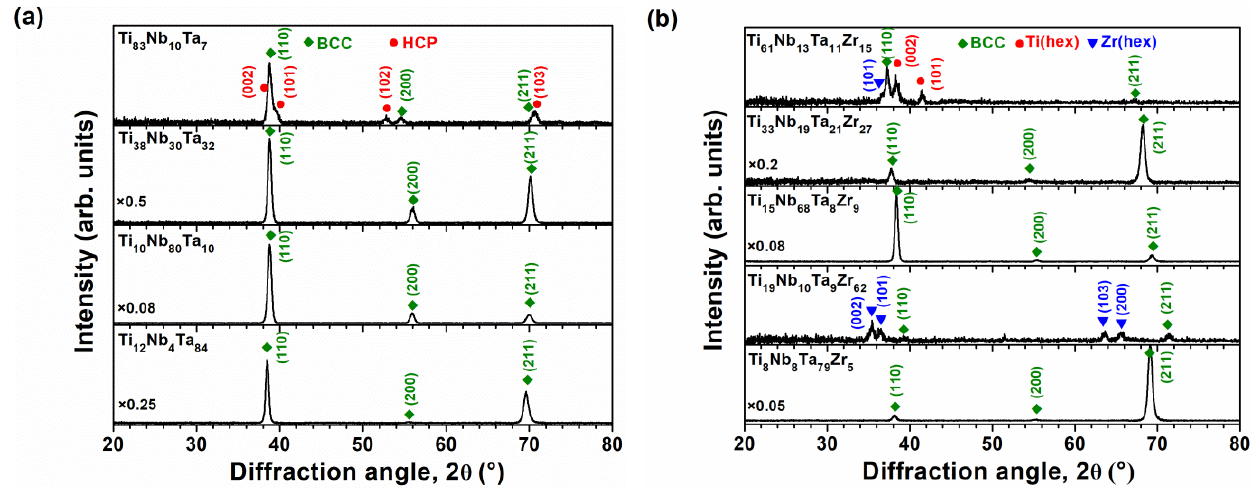
Figure 1. XRD patterns of ( a ) TiNbTa and ( b ) TiNbTaZr films.